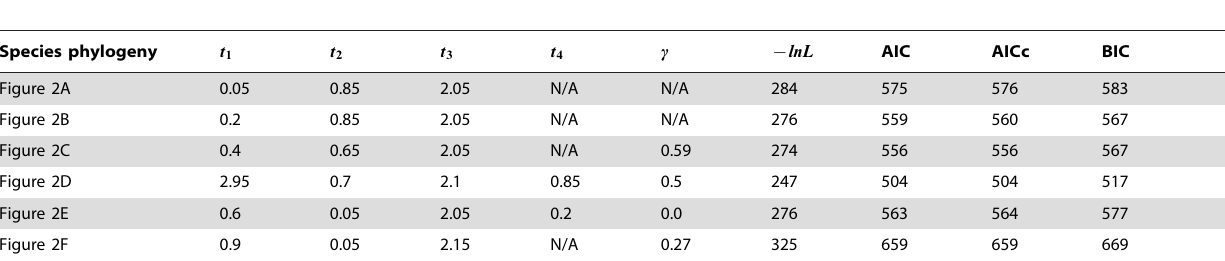
Table 1. Analysis results for the six phylogenies in Figure 2 using gene tree topologies inferred by a Bayesian analysis (using MrBayes).